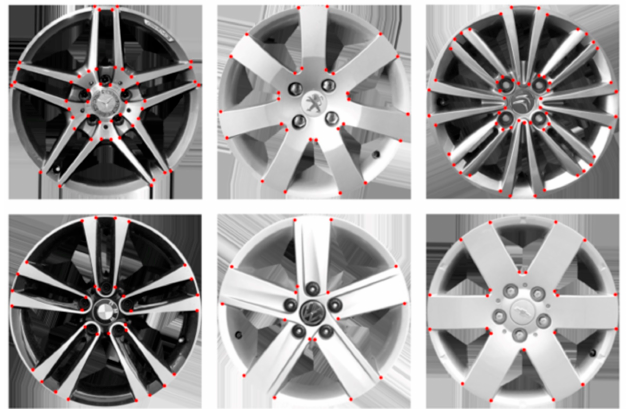
Figure 10. Training results of the feature point extraction model. The top row is for training and the bottom row, for validation. According to the output, it shows that box_loss (train) = 0.036, box_loss (val) = 0.022, obj_loss (train) = 0.128, obj_loss (val) = 0.088, precision rates = 0.994, and recall rates = 0.983, indicating that the feature point detection met the research expectation.